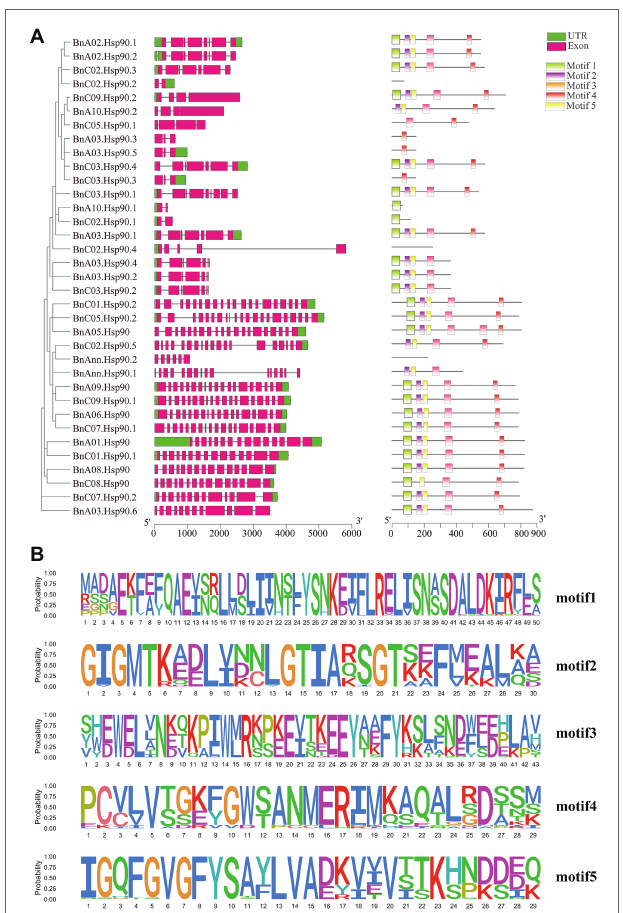
FIGURE 2 | Gene structure and motif analysis of BnHSP90s . (A) left, Intron and exon structure of the B. napus BnHsp90 genes according to the phylogenetic relationships. The untranslated region (UTR) and exon are indicated as green and pink boxes, respectively. The gray line represents introns. A, right, Distribution of the BnHsp90 conserved motifs in B. napus . There are five types of conserved motifs, which are represented by light green, purple, orange, red, and yellow. (B) MEME motifs are stacked by letters at each investigated site. The x-axis represents the width of the motif, whereas the y-axis represents the frequency of each letter.